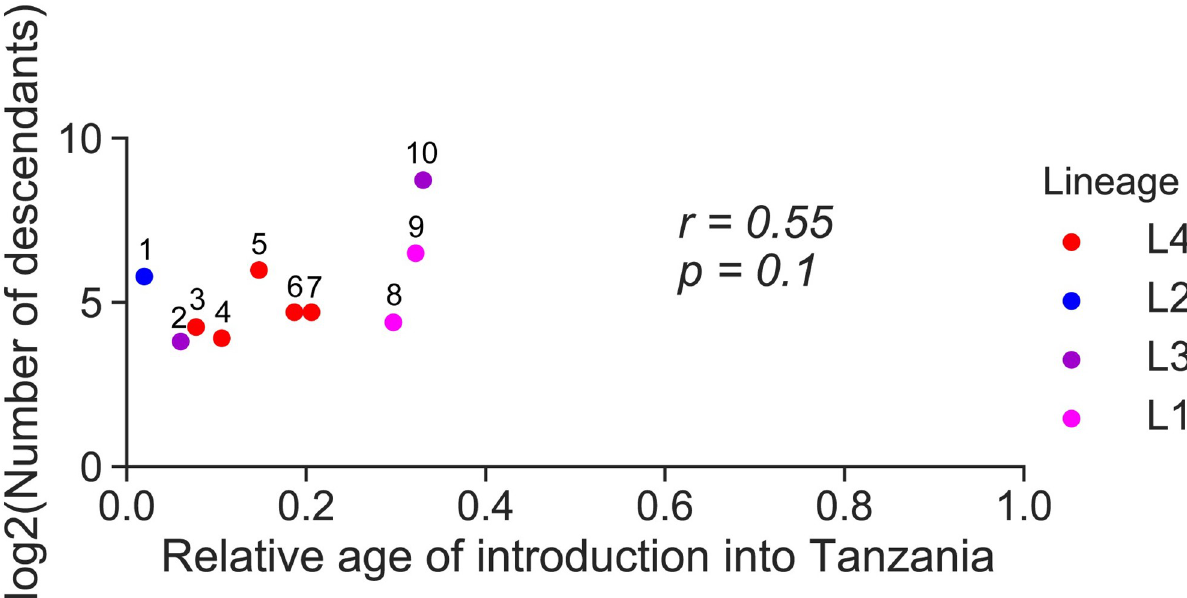
Fig 3. Number of descendants resulting from the ten most successful introductions and the relative age of the latter. The number above each introduction corresponds to the numbers in Figs 1 and 2. The pearson correlation coefficient (r) and p-value (p) were calculated.